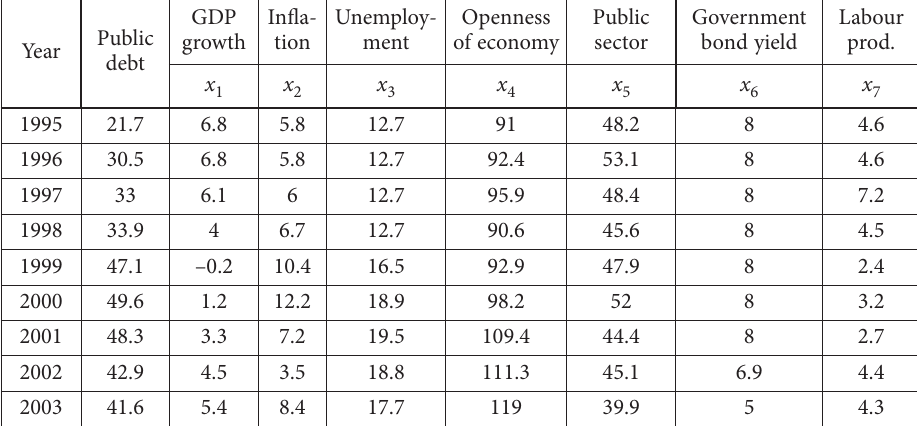
Table 1. Macroeconomic indicators for the period 1995 to 2017 (in %) (source: own data processing from Eurostat,